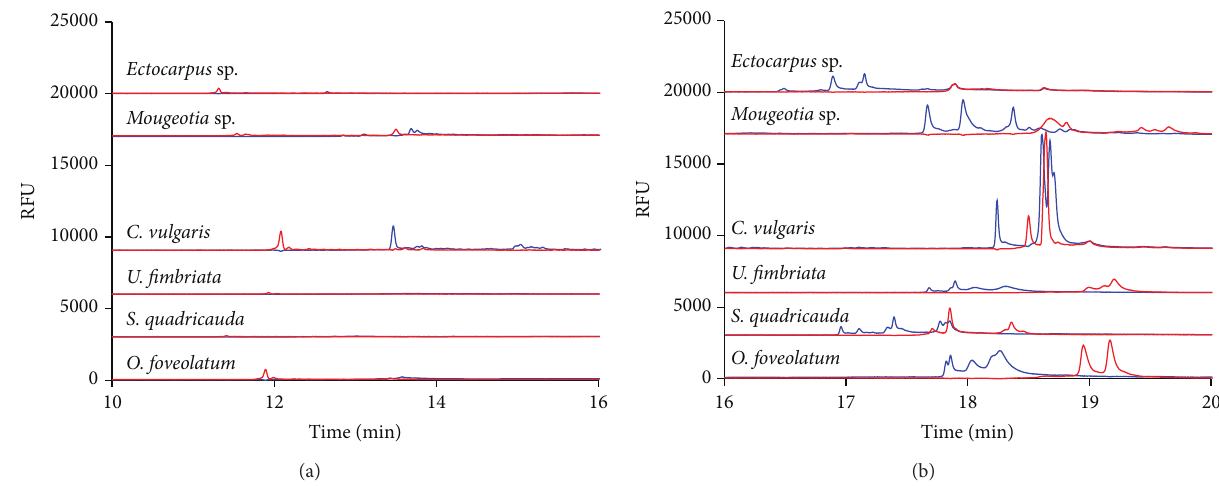
Figure 4: Detection of the (a) early and (b) later migrating peaks formed from the 18S rDNA variable region 9 as detected by CE-SSCP for the green and brown algae. Forward or sense strands are represented in blue while reverse or antisense strands are represented in